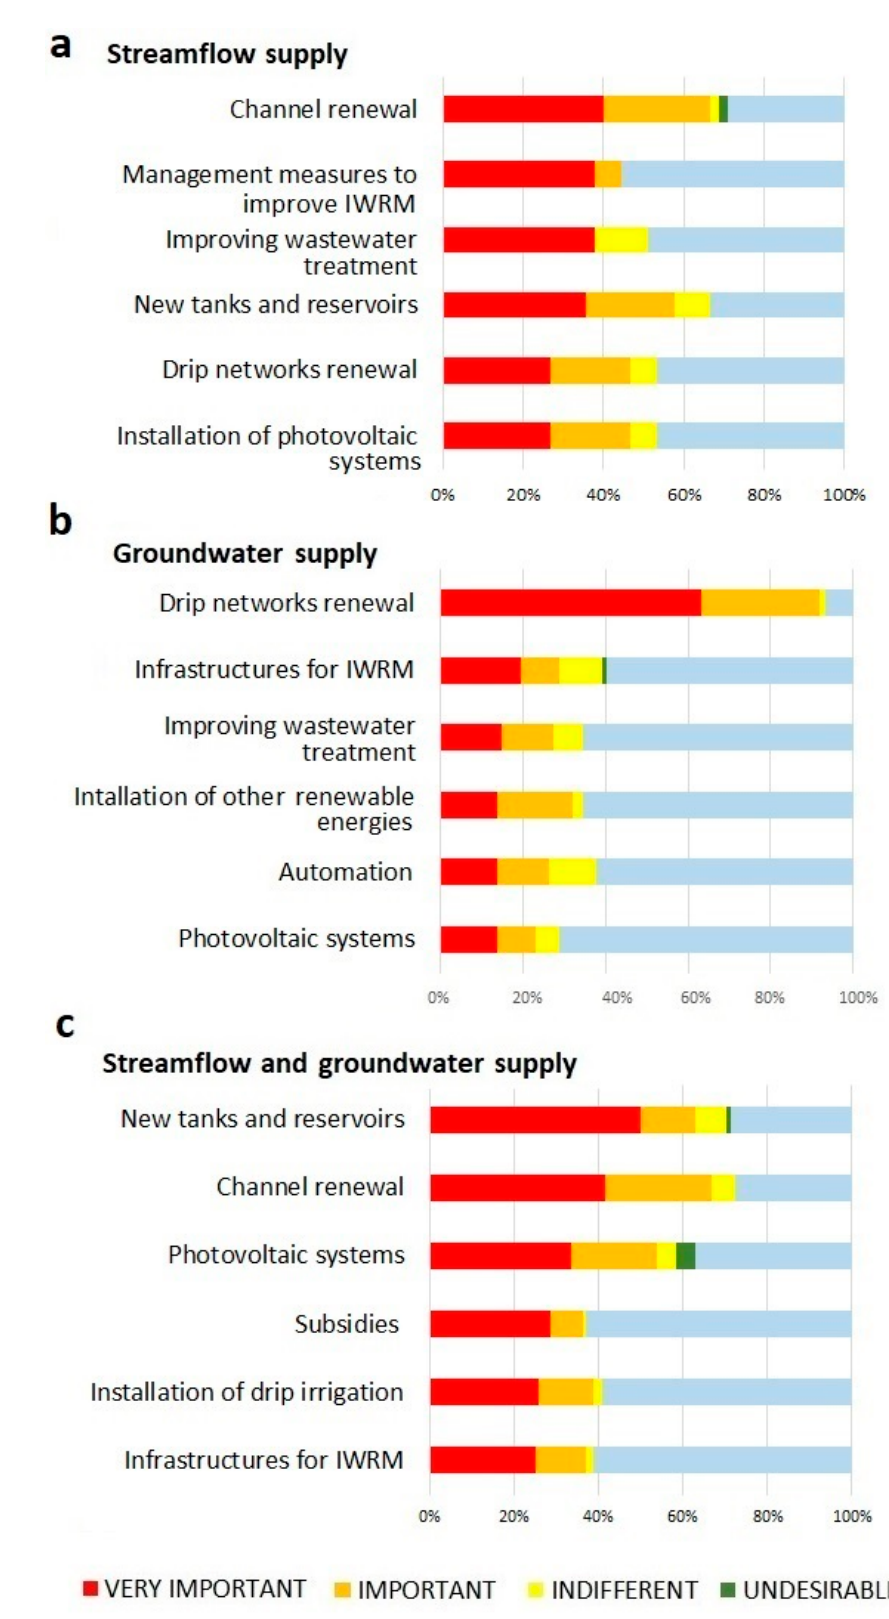
Figure 9. Measure evaluation according to the origin of water resources: evaluated in terms of percentage of total votes. ( a ) Streamflow supply; ( b ) Groundwater supply; ( c ) Mixed streamflow and groundwater supply.